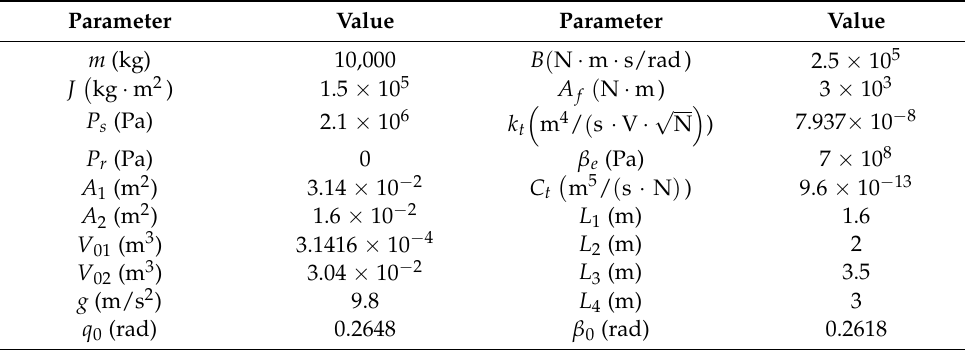
Table 1. Physical parameters of the hydraulic lifting